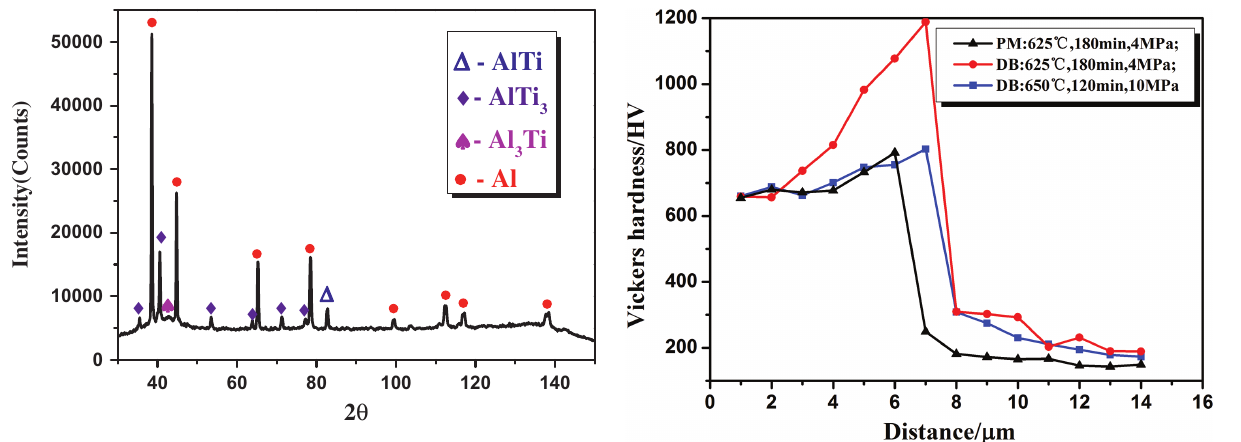
Figure 5: The selected area XRD result on the DB bonds.